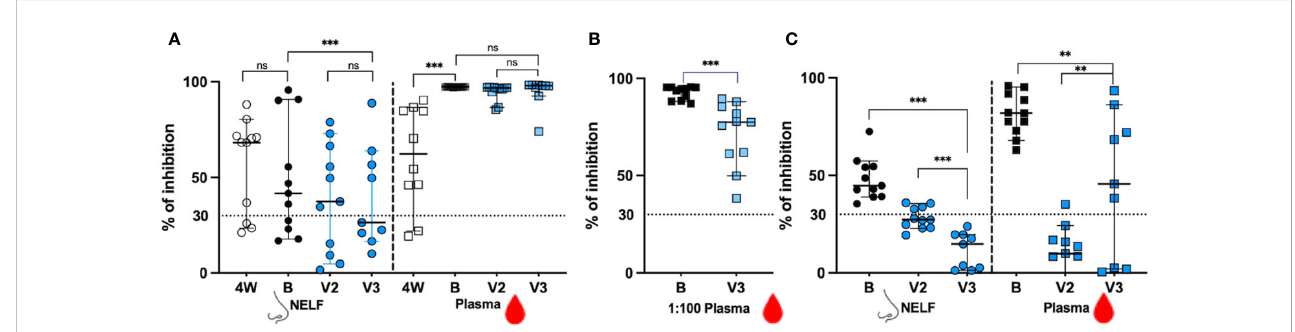
FIGURE 3 The signal inhibition in the surrogate ACE-2-based neutralization readout. (A) The percentage of signal inhibition against ancestral RBD of SARS-CoV-2 by NELF (circle) and plasma (square) of recovered patients (4W: 4weeks after onset; B: 2 weeks post booster) and vaccine-only subjects (V2: 4 weeks post 1 st dose; V3: 2 weeks post 3 rd dose) are plotted. (B) Plasma diluted at 1:100 dilution was used to provide a better resolution to examine the differential neutralization ability between recovered (black square) and control (blue square) subjects. (C) The percentage of signal inhibition against SARS-CoV-2 omicron BA.1 by NELF and plasma of recovered patients after booster (B:2 weeks post vaccination) and vaccine-only subjects (V2: 4 weeks post 1 st dose; V3:2 weeks post 3 rd dose) are plotted. The ≥ 30% signal inhibition cutoff for SARS-CoV-2 NAb detection is interpreted as the sample containing neutralizing antibodies for SARS-CoV-2, indicated by the horizontal dotted line. The median and the 95% CI are shown. Comparison was performed with a Wilcoxon matched-pairs rank test. The asterisks indicate the statistical differences found; **: p <0.01. ***: p <0.005 and ns: not signi fi